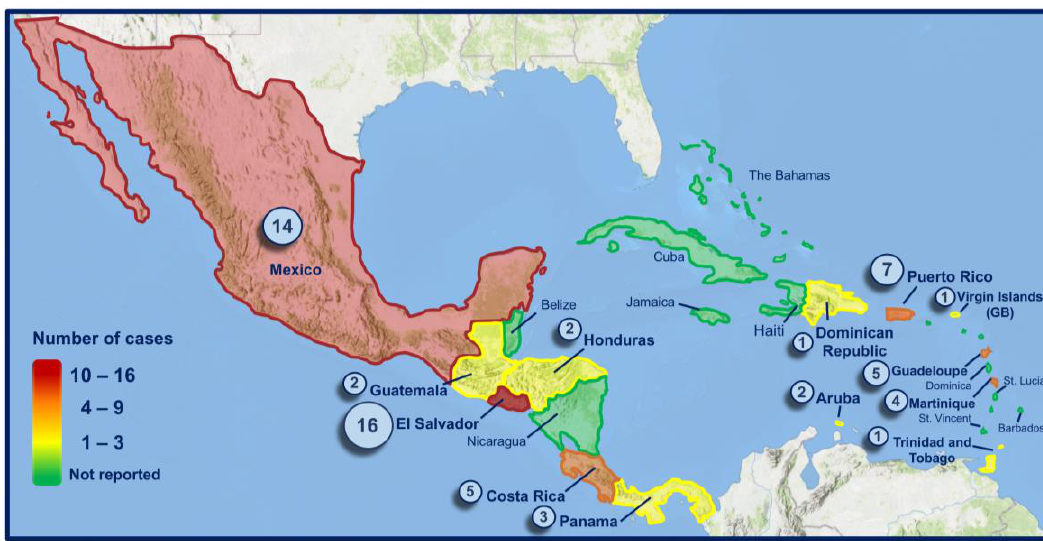
Figure 1. Melioidosis cases reported (1945 – 2017). Adapted from: Esri, HERE, DeLorme, increment P corp., NPS, NRcan, Ordnance Survey, OpenStreetMap contributors, USGS, NGA, NASA, CGIAR, N Robinson, NCEAS, NLS, OS, NMA, Geodatastyrelsen, Rijkswaterstaat, GSA, Geoland, FEMA,